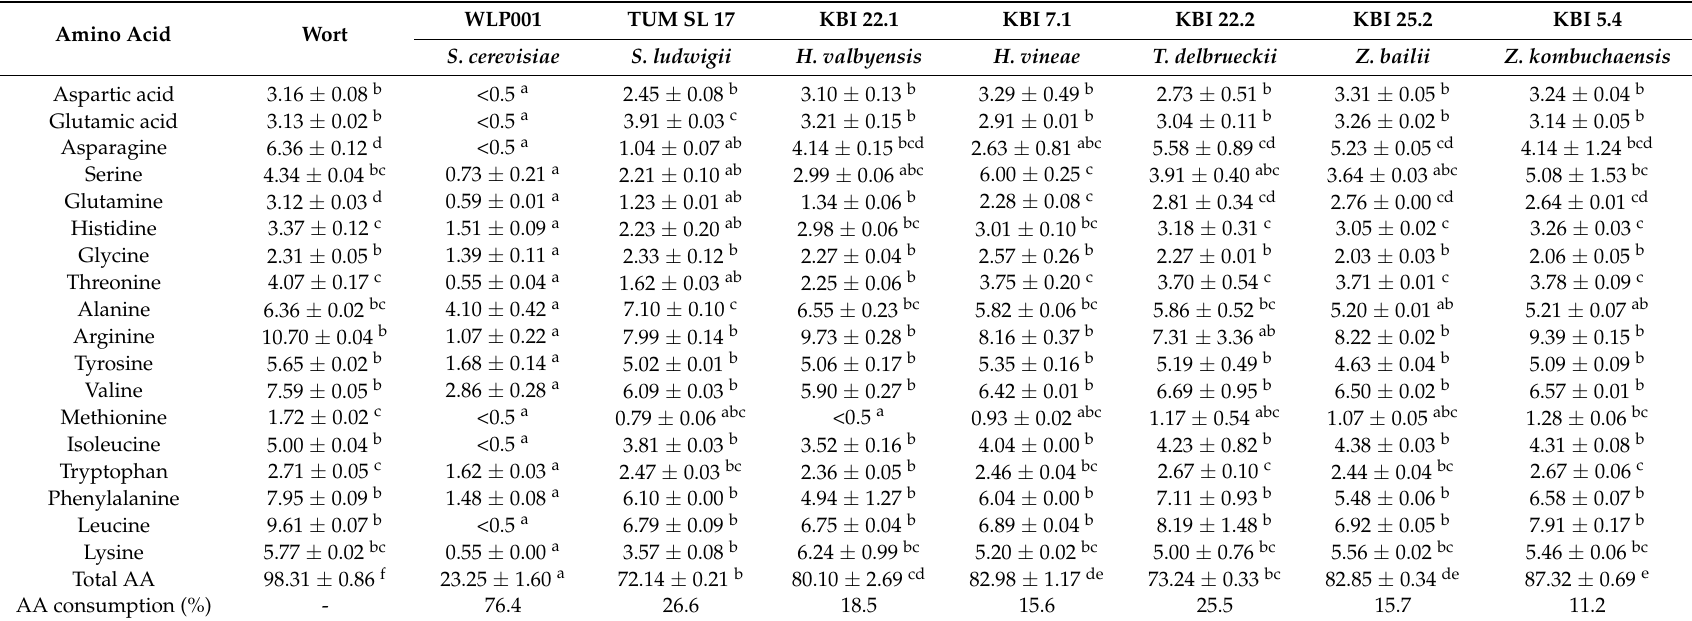
Table 5. Amino acid analysis of wort and final beers fermented with the investigated strains; values in mg/100